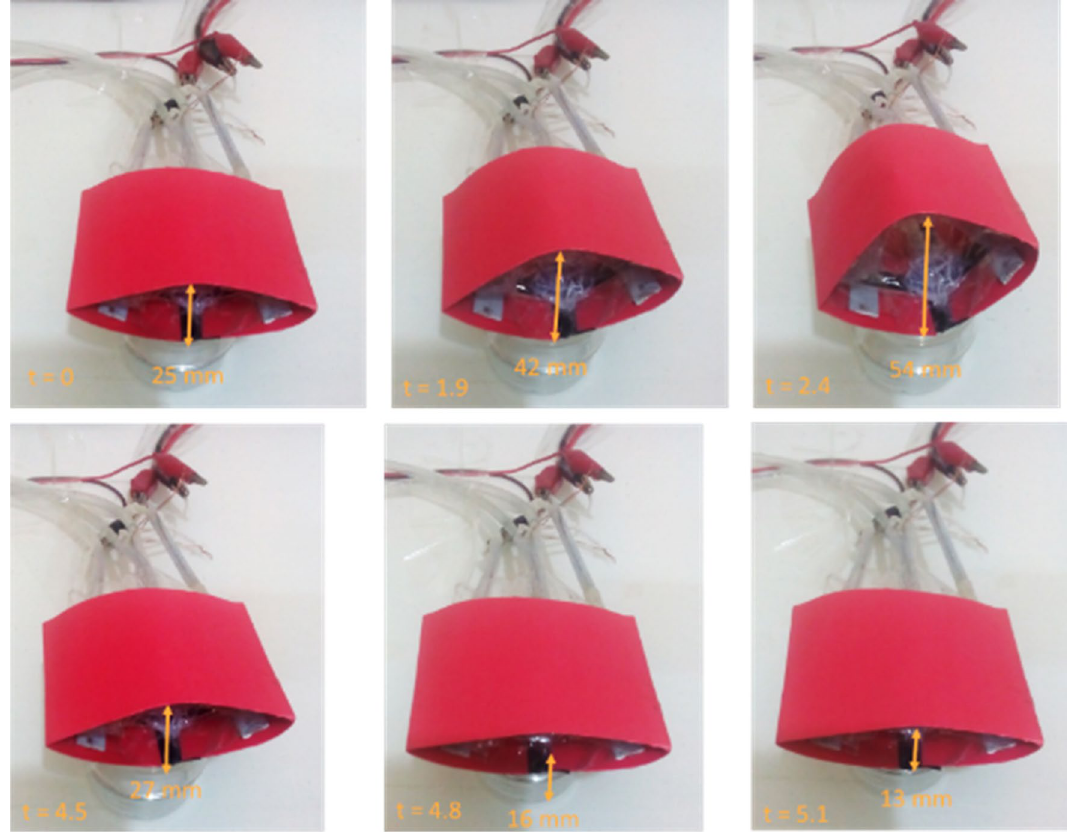
Figure 7. Variation of thickness of small airfoil over time using HEFR technique.